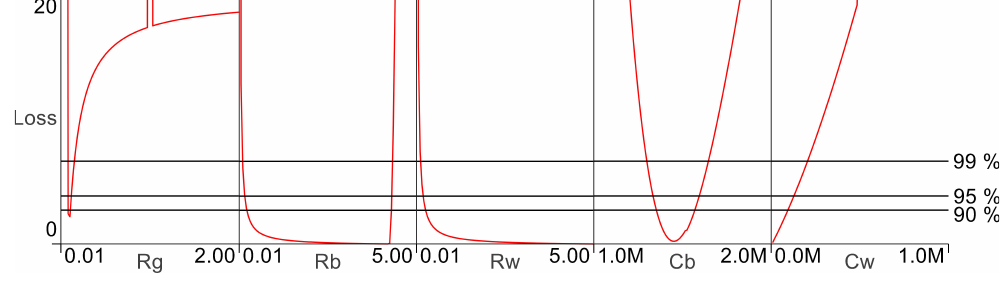
Figure 19: PL1 results for the R3C2 model.